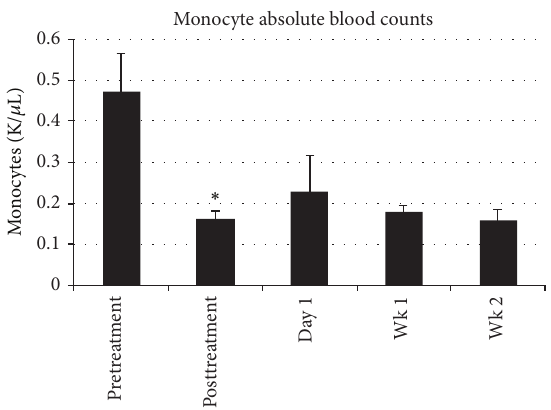
Figure 7: Systemic absolute monocyte blood count was lowered with SCD treatment from 0.47 ± 0.09 (pretreatment) to posttreat- ment of 0.16 ± 0.02 K/ 𝜇 L ( 𝑛 = 9 , 𝑝 = 0.007 ( ∗ )). This lower monocyte count persisted at the 1-week ( 0.18 ± 0.02 K/ 𝜇 L) and 2- week ( 0.16 ± 0.02 K/ 𝜇 L) posttherapy monitoring periods.